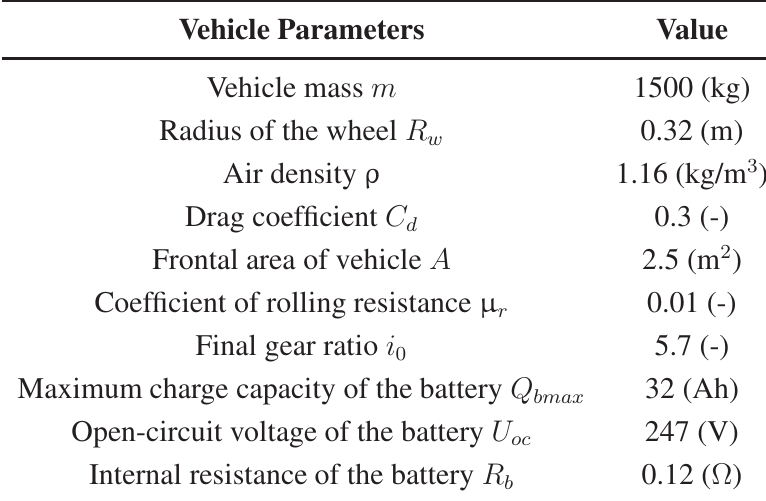
Table 2. Parameters of the